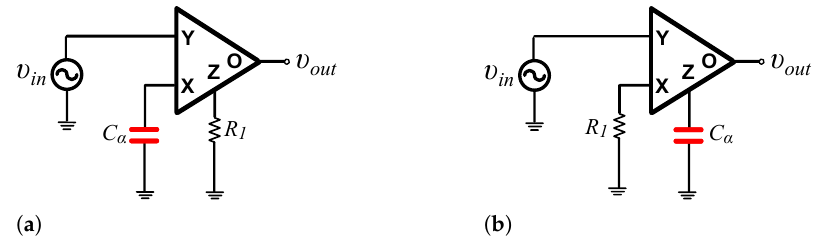
Figure 1. CFOA-based implementations of fractional-order ( a ) differentiator, and ( b ) integrator.